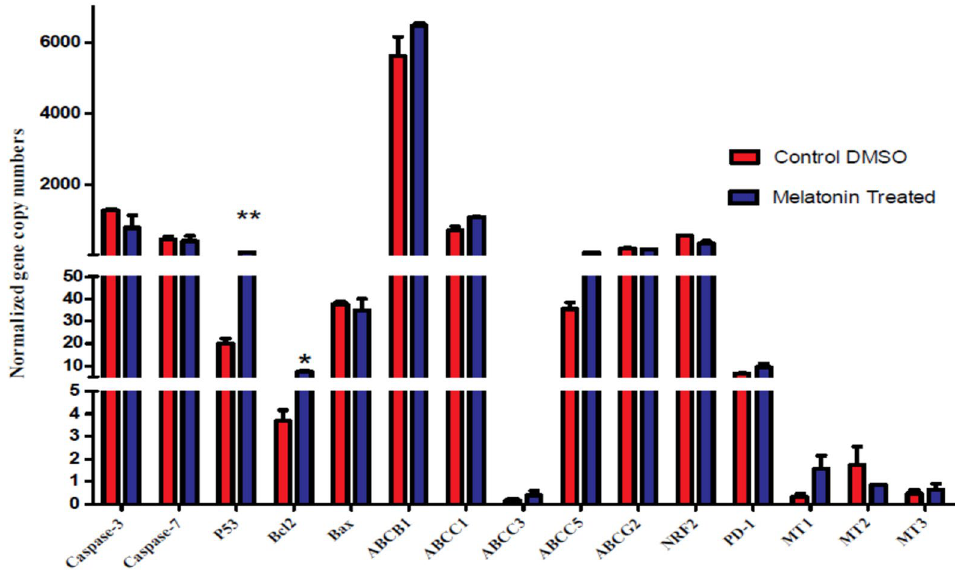
Figure 3. The gene expression pattern verification by qRT-PCR. The effect of 1 mM melatonin for 24 h on genes expressions of wild HepG2 cells using qRT-PCR shows a highly significant increase in the P53 gene expression level ( P < 0.01), and a significant increase in the Bcl2 gene level ( P < 0.05) that is associated with a slightly decreases in the expression levels of pro-apoptotic genes caspase-3, caspase-7, and BAX. Observed increases in the expression levels of genes contributed to drug resistance including ABCB1 , ABCC1 , and ABCC5 are additionally